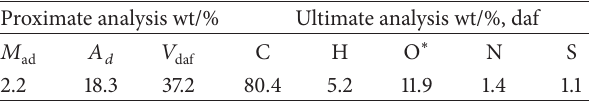
Table 1: Proximate and ultimate analysis of PS coal. Proximate analysis wt/% Ultimate analysis wt/%, daf